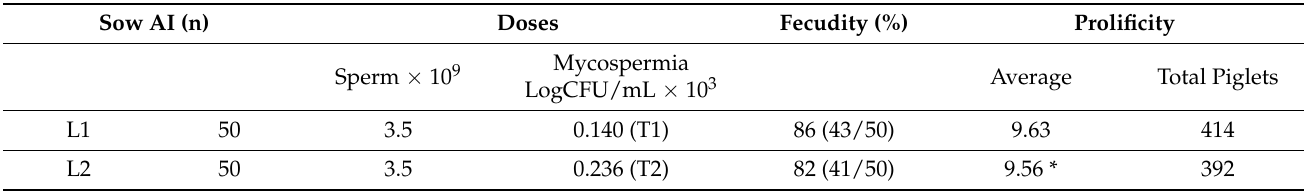
Table 3. Fertility and comparative prolificacy of sows inseminated with doses of semen with known mycological